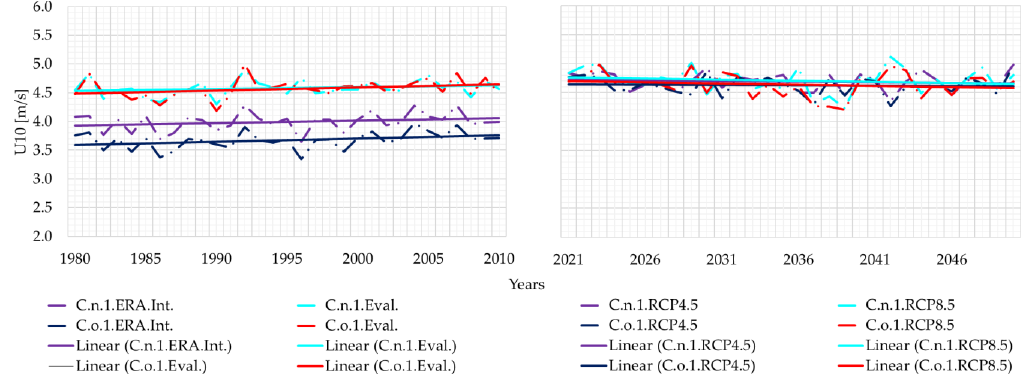
Figure 5. Annual averages of the wind speed at 10 m height annual averages for two of the most representative points located in deep water Bulgaria (B.o.1) and Romania (A.o.1). ERA.Int and Eval data, time interval 1981–2010, RCP4.5 and RCP8.5 data, time interval 2021–2050. Energies 2018 , 11 , x